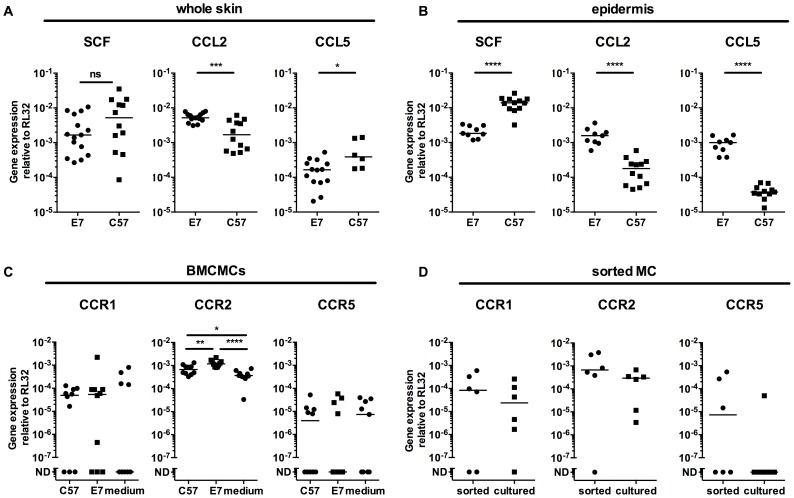
E7 epidermis produce CCL2 and CCL5 and MCs express the corresponding receptors.(A) C57 and E7 whole skin, or (B) C57 and E7 epidermis, were analyzed for SCF, CCL5 (Rantes) and CCL2 (MCP-1) gene expression. Data are combined from 2 independent experiments. CCR1 and CCR5 (two Rantes receptors) and CCR2 (MCP-1 receptor) gene expression in (C) BMCMCs after 72 h culture in E7 or C57 ear skin culture supernatant or medium (n = 10 different batches of BMCMCs; data are combined from 4 independent experiments. ND, not detectable) and (D) Mast cells sorted from E7 ear skin (n = 6 independent experiments, each with 4 or 5 mice pooled per treatment). Gene expression was performed by real time-PCR relative to the RL32 housekeeping gene. *p<0.05; **p<0.01; ***p<0.001; or ****p<0.0001 by unpaired t-test for indicated comparisons; ns  =  not significant.